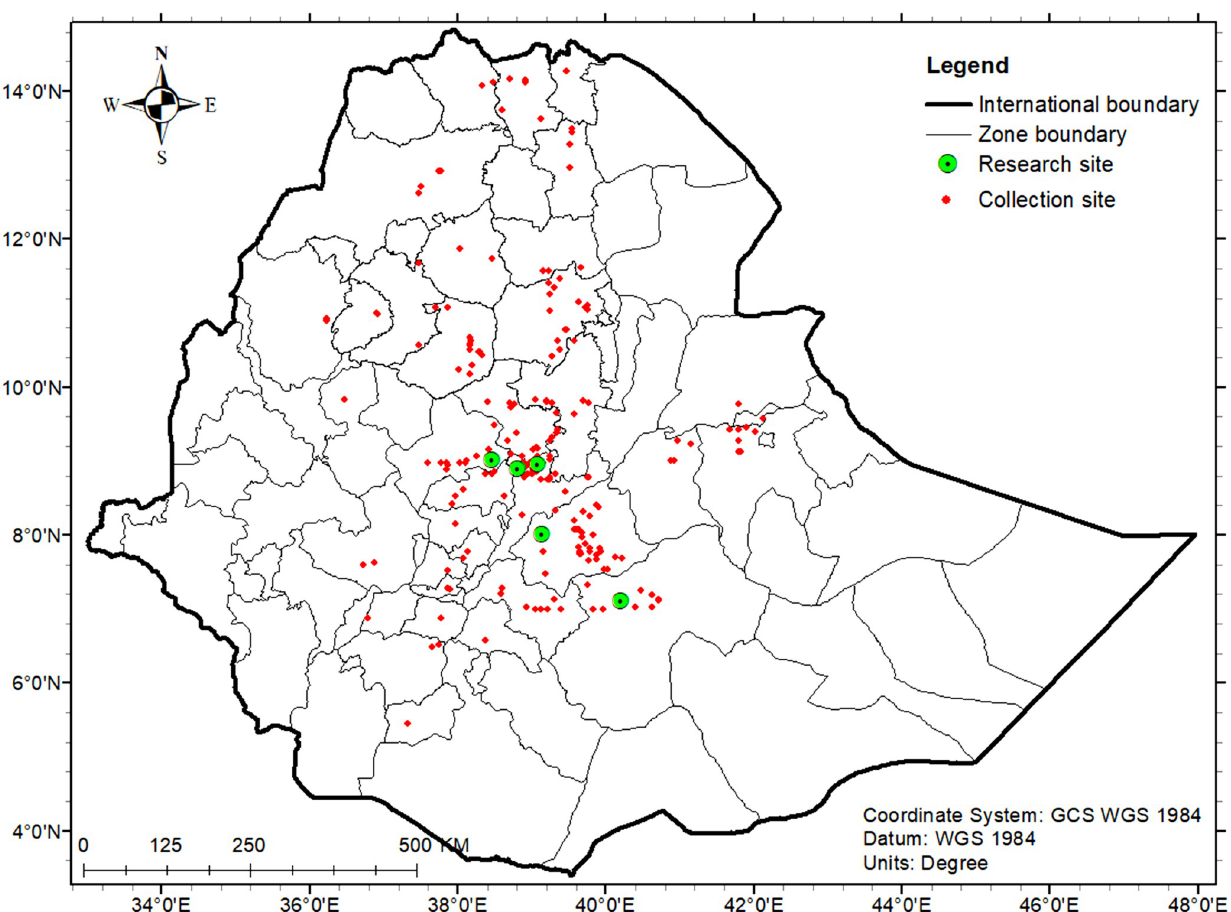
Fig 1. Map of Ethiopia showing the test sites (green circles) and the original germplasm collection sites of the landrace used in this study (red rhombus).